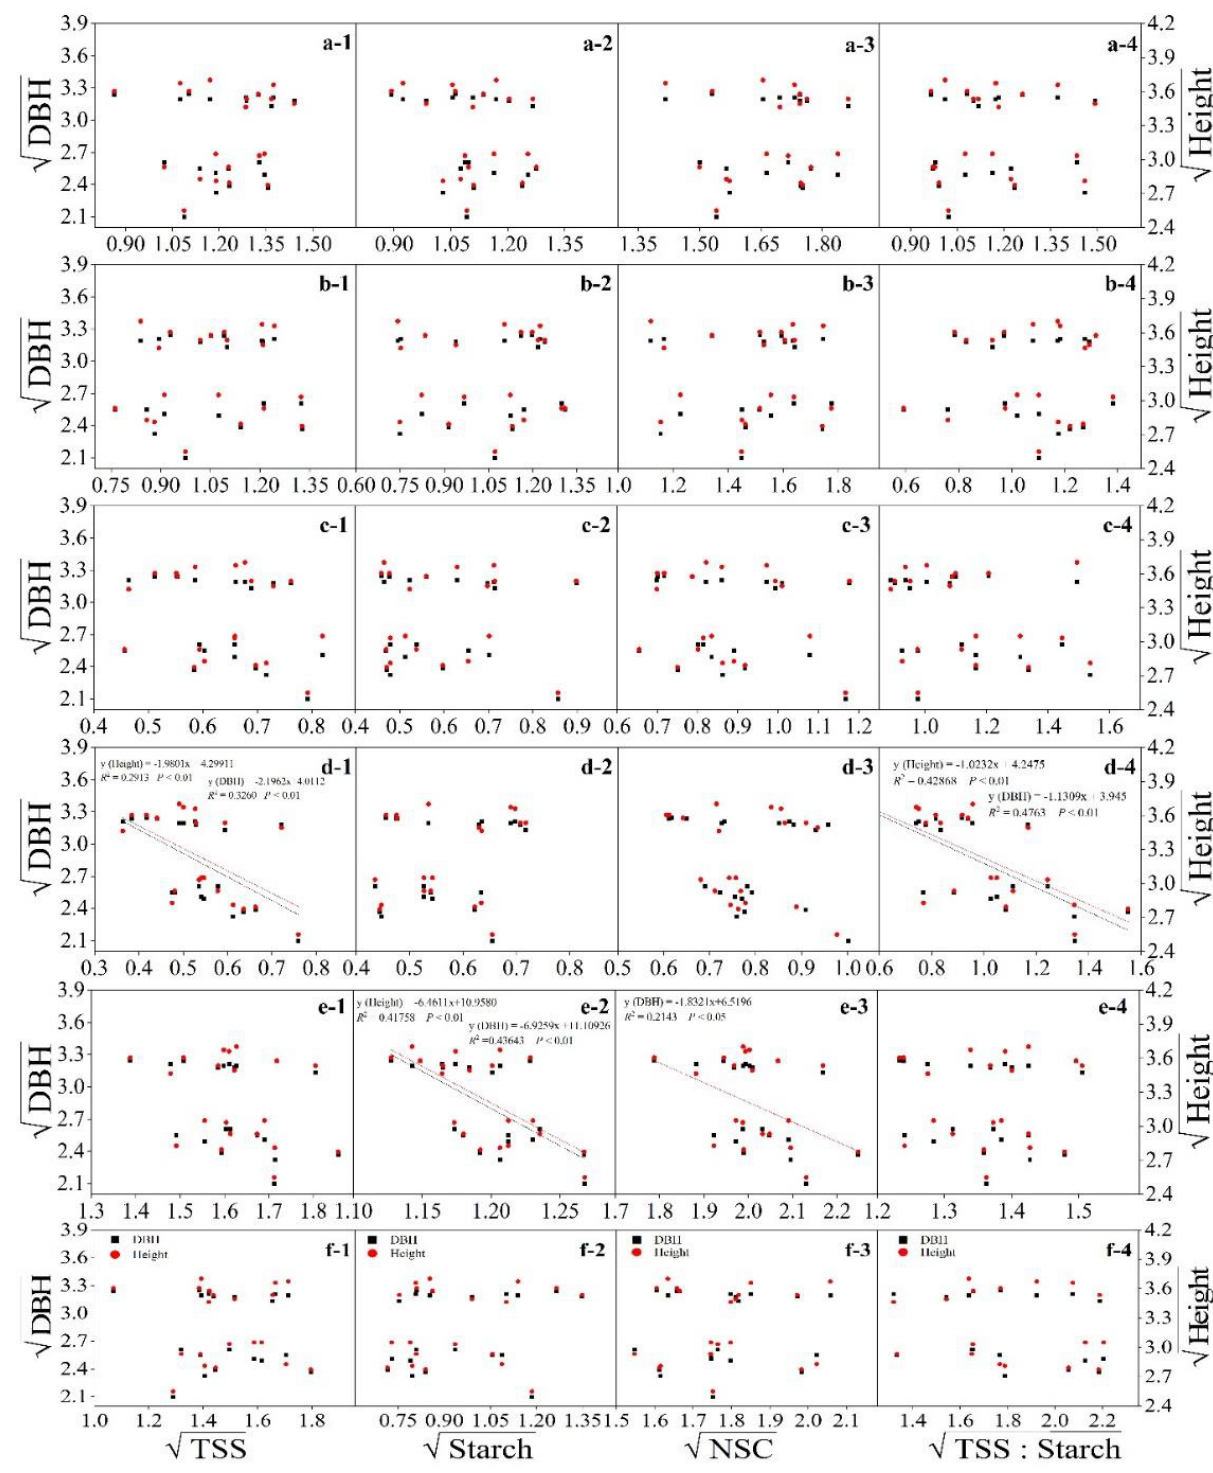
Figure 5. The correlations of NSC and growth indexes. Relationships of ( a ) branchlet, ( b ) old branch, ( c ) stem xylem, ( d ) stem cambium, ( e ) leaf and ( f ) root with ( 1 ) total soluble sugar (TSS), ( 2 ) starch, ( 3 ) non-structural carbon (NSC) and ( 4 ) ratio of TSS to starch. All data were square root transformed to improve normality and homoscedasticity before linear regression analysis and Pearson correlation analyses were used to obtain regressions and correlations ( R 2 and p values).